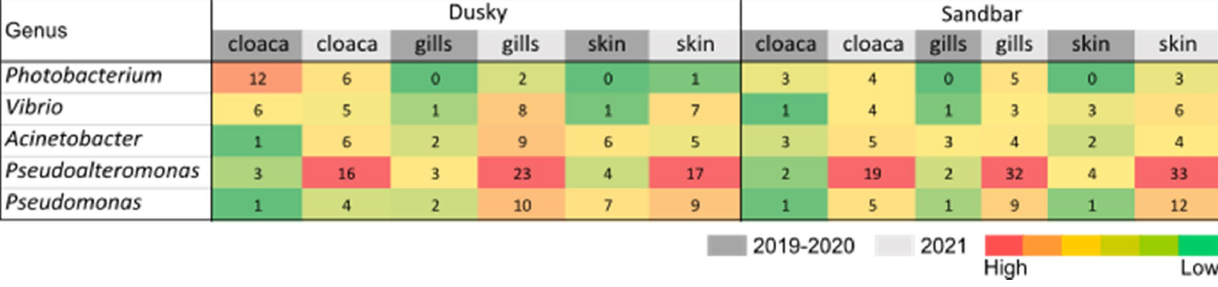
The numbers shown represent percentages of relative